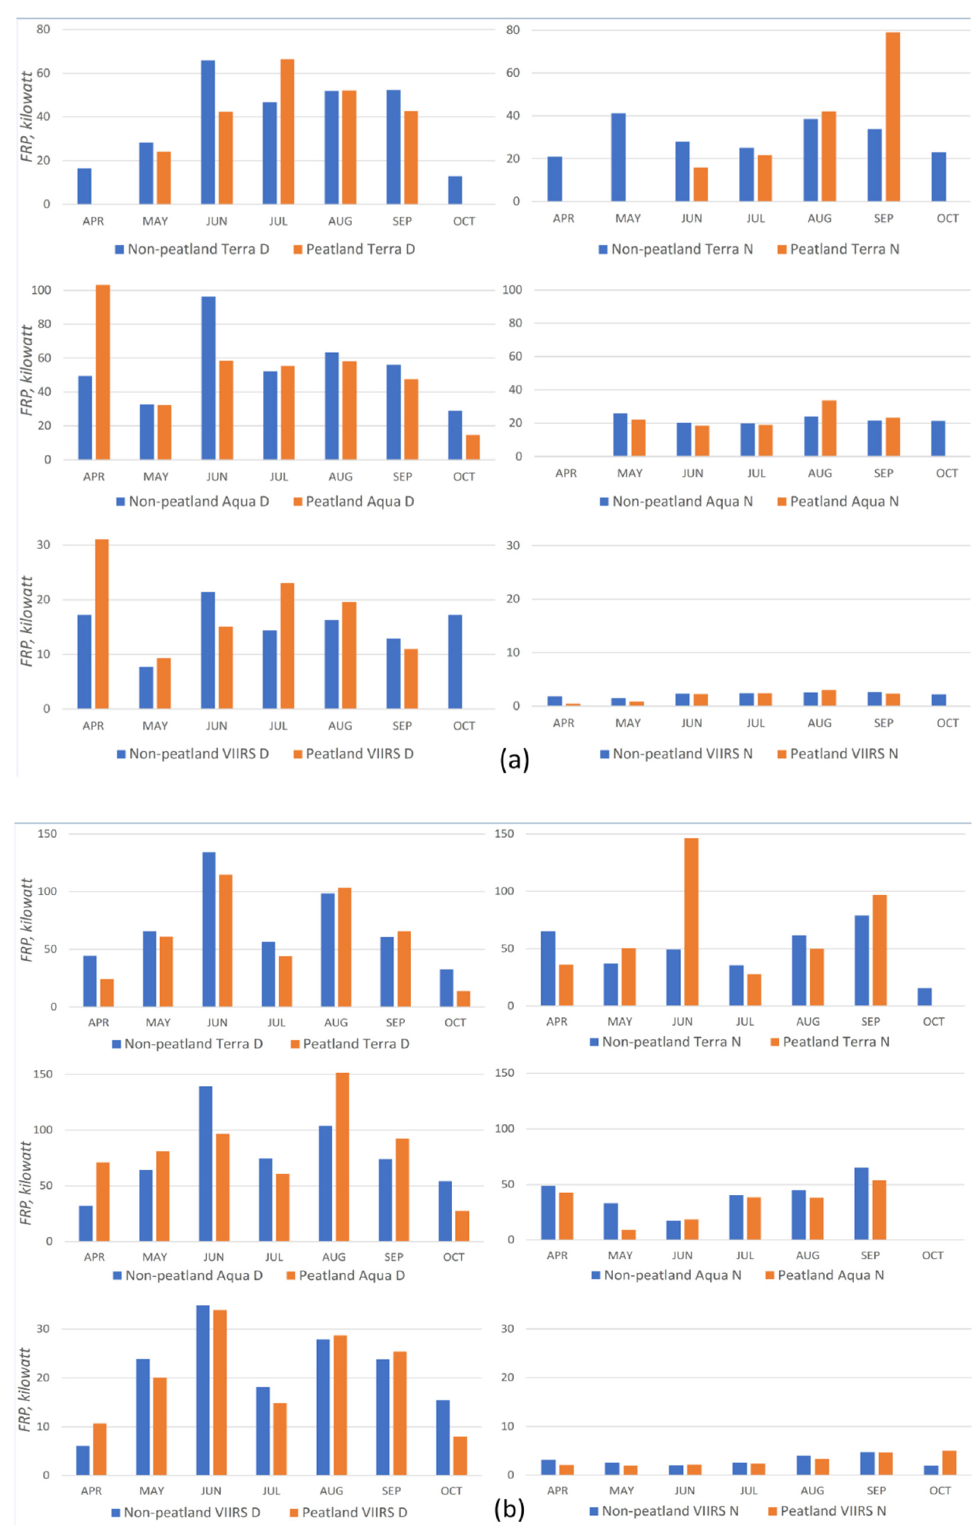
Figure 7. Seasonal dynamics of Fire Radiative Power (FRP) across bog and non-bog areas: ( a )—Tokma area; ( b )—Khanda area.